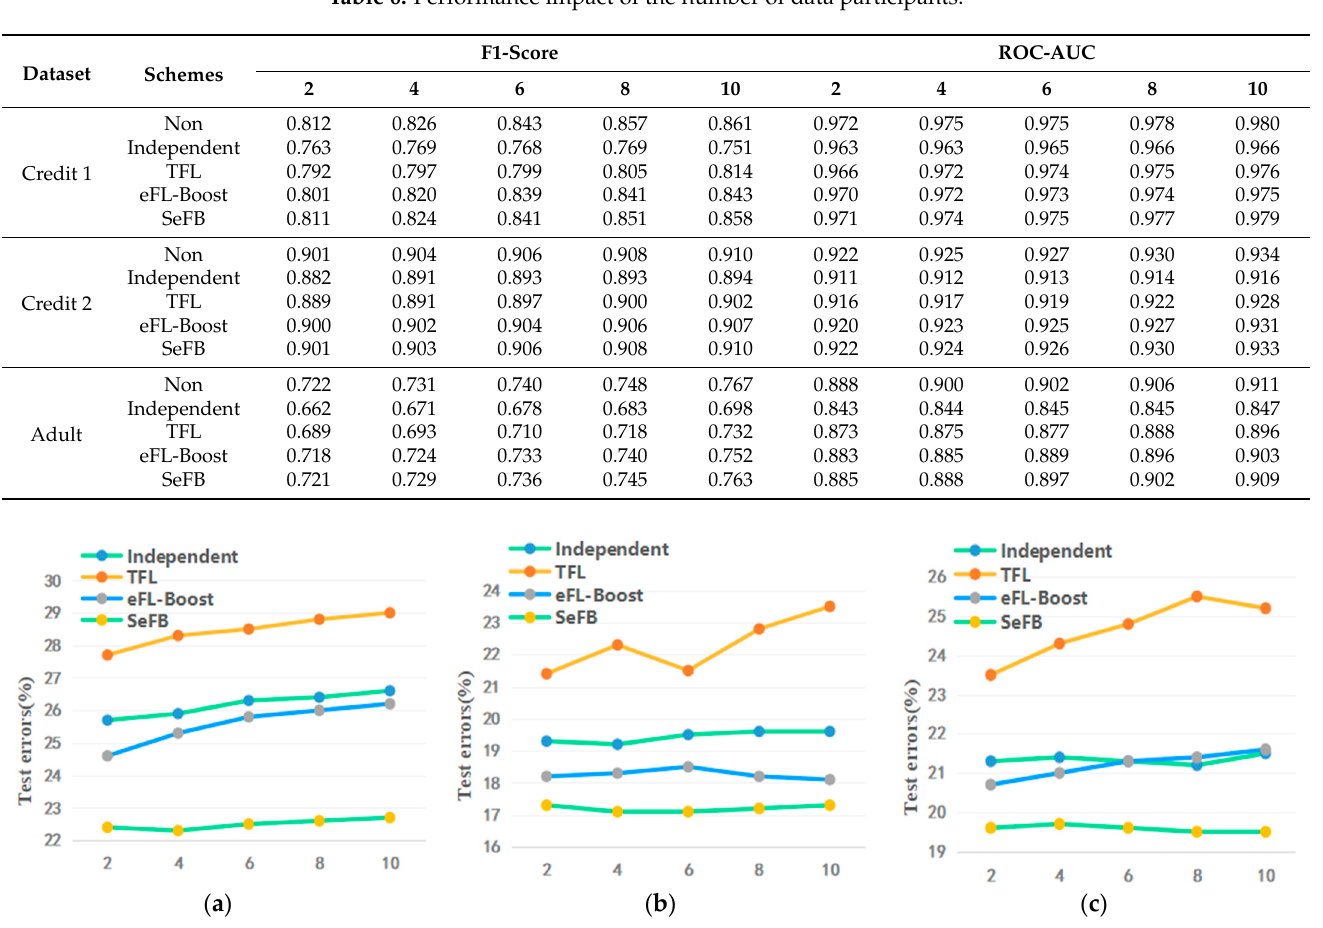
Table 6. Performance impact of the number of data participants.